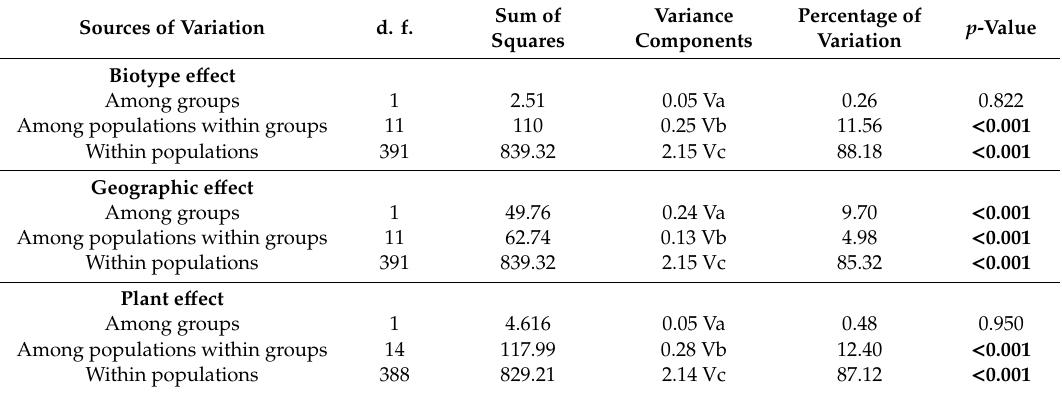
Figure 6. A scattered plot of genetic variation F ST / (1- F ST ) vs. geographic distance for Sitobion avenae populations. Table 4. Analyses of molecular variance (AMOVA) for e ff ects of biotype, geography and plant in the divergence of Sitobion avenae Table 3. Pairwise genetic distance estimates ( F ST ) for two Sitobion avenae biotypes from nine provinces.